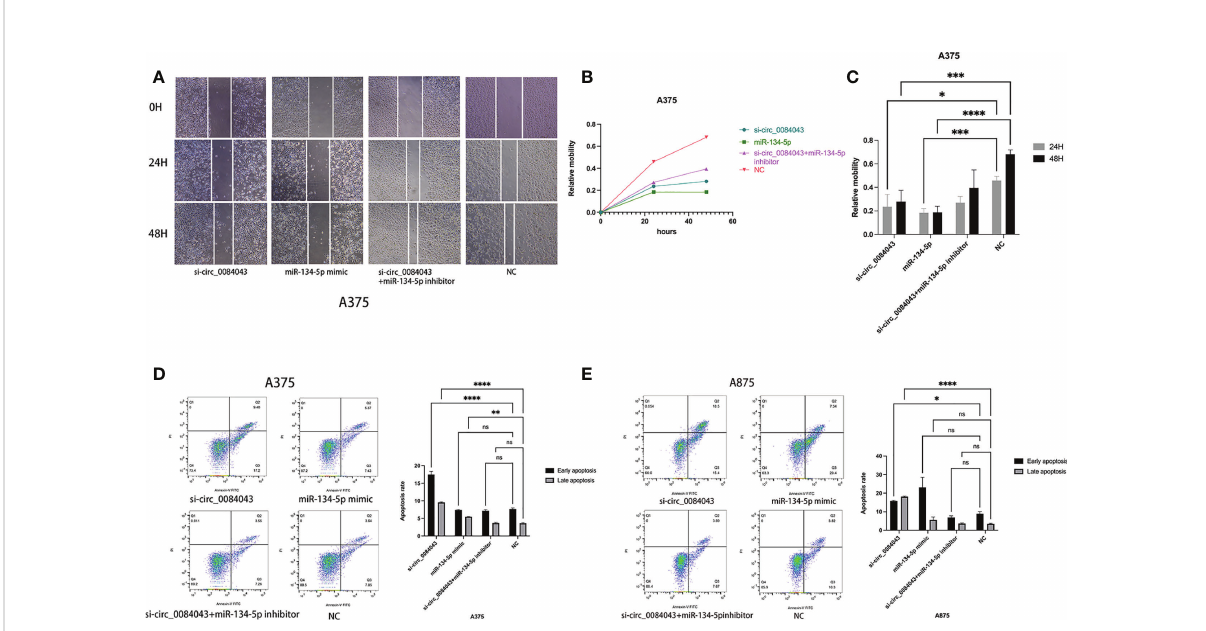
FIGURE 6 The cell migration ability of A375 cells was detected by scratch wound assay (A – C) . Apoptosis was determined by fl ow cytometry after transfection for 48 h (D, E) . Data represent mean ± SD from three independent experiments. * p < 0.05, ** p < 0.01, *** p < 0.001, and **** p < 0.0001 compared groups using one-way ANOVA followed by least signi fi cant difference post-hoc tests.